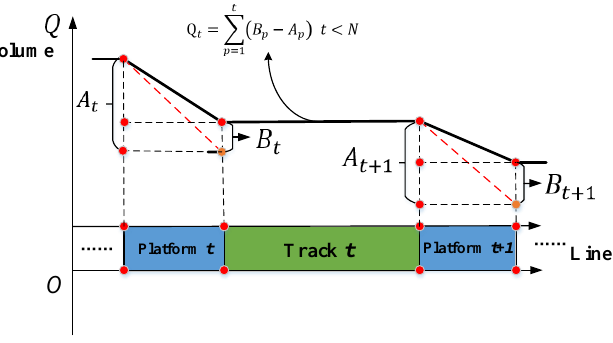
Figure 4. Passenger volume in each track t